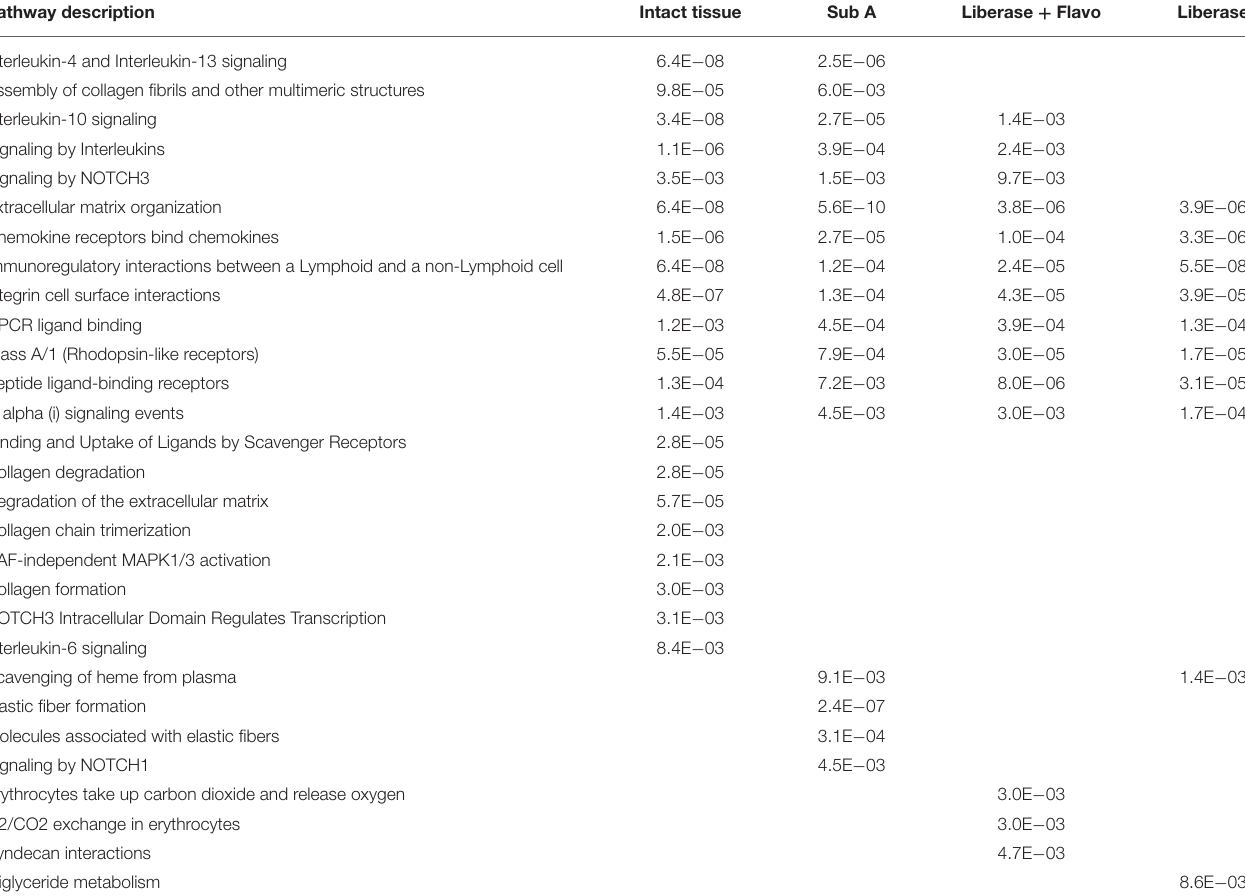
TABLE 2 | Differential pathways lost or enriched by each disaggregation protocol relative to intact tissue. Pathway